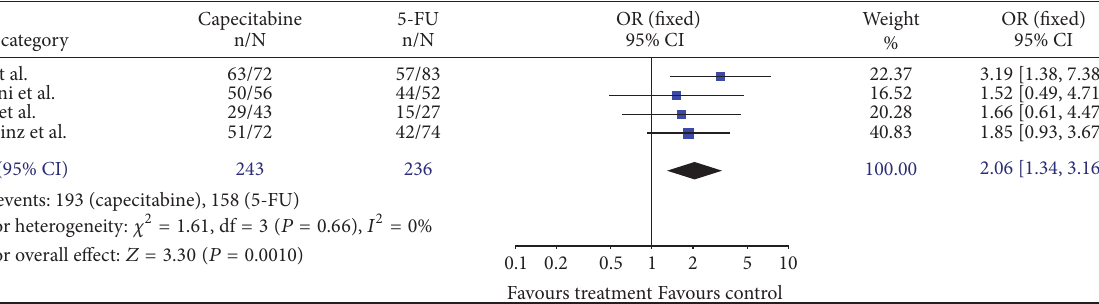
Figure 5: Forest plot of odds ratio (OR) for N downstaging rate.